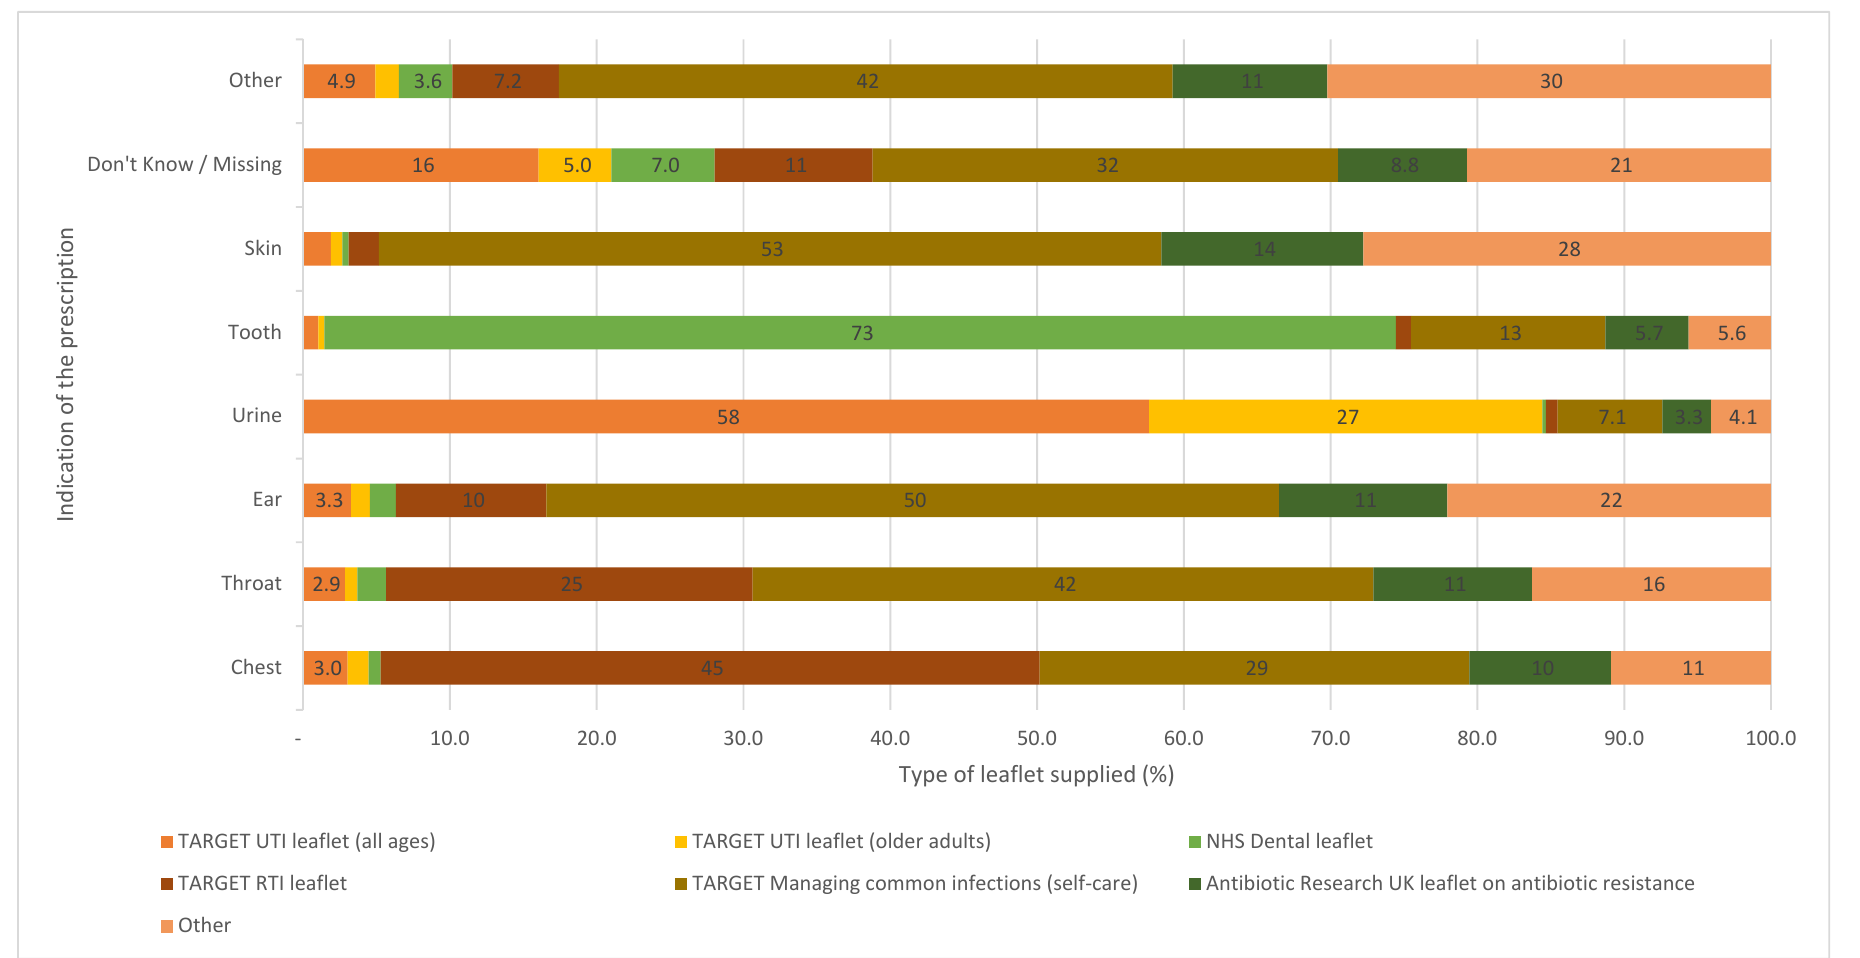
Figure 3. Percentage and type of supporting information leaflets provided to patients by antibiotic checklist reported indication.